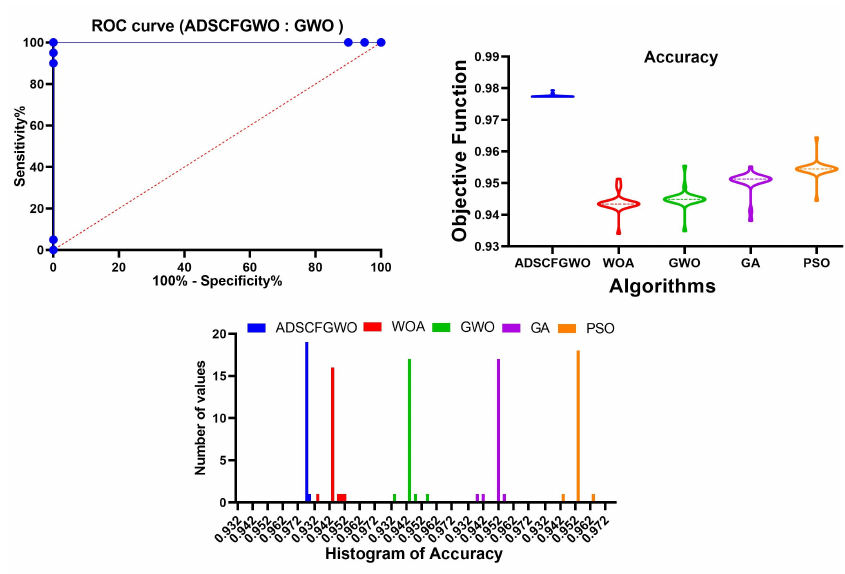
Figure 7. ROC, accuracy, and histogram plots of the ADSCFGWO and compared algorithms.